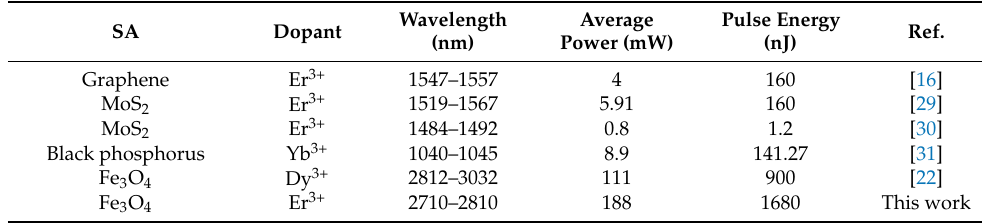
Table 1. Passively Q-switched wavelength-tunable fiber